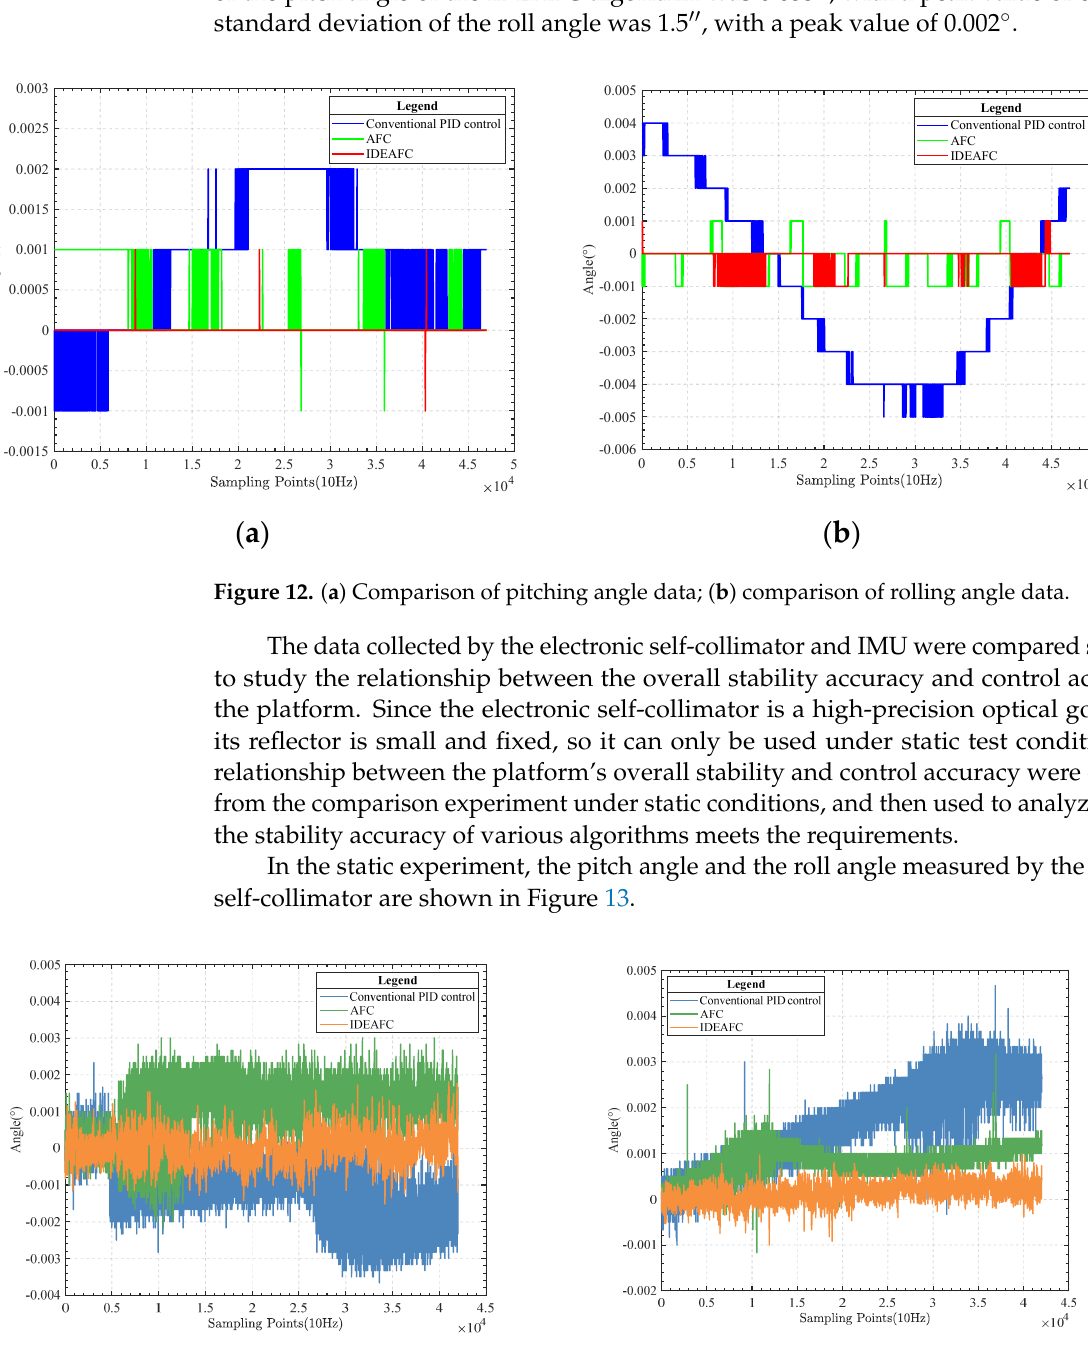
Figure 13. ( a ) Comparison of static pitch angle data; ( b ) comparison of static roll angle data. A comparison of the control effects of the three control algorithms can be obtained from the comparison chart, as shown in Table 2. The improvement in accuracy was calculated as follows. Relative comparison algorithm precision improvement ratio = (comparison algorithm precision − target algorithm precision)/comparison algorithm